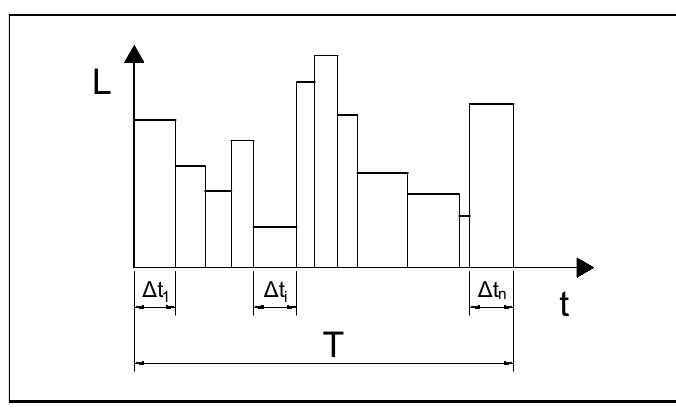
Figure 6. Load L variation during the period, T